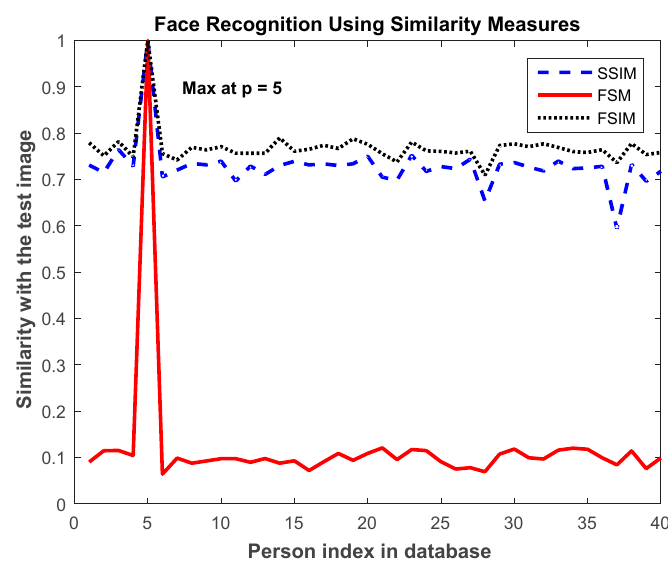
Figure 9. Performance of similarity measures using person No. 5 (pose 7) in the FEI database. Confidence in recognition for SSIM, FSIM and FSM is 0.2354, 0.2103 and 0.8791 respectively.